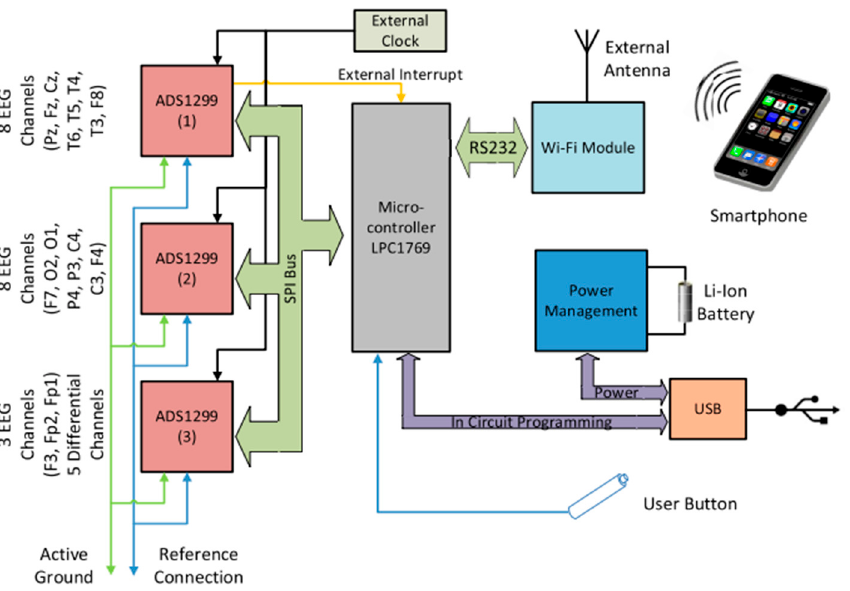
Figure 18. The system functional block diagram of key subsystems and their interconnections [160].